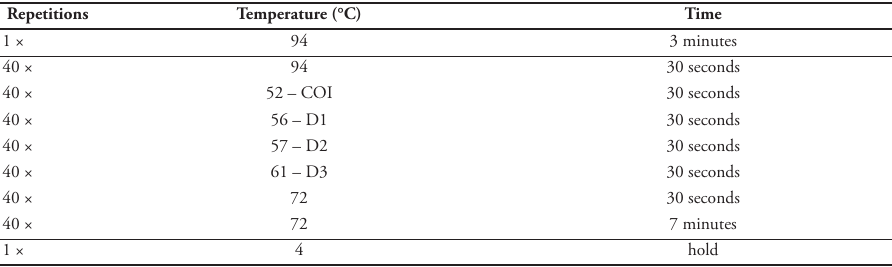
Table 4. PCR settings (cycles, temperature, time) for each targeted gene